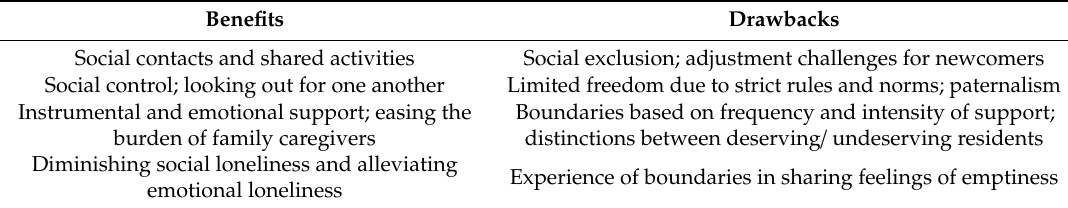
Table 3. Overview benefits and drawbacks of